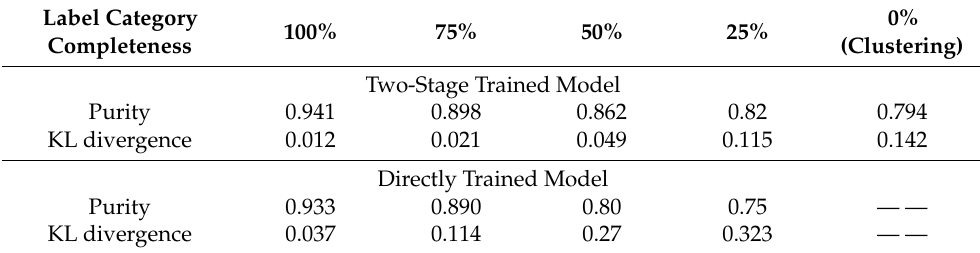
Figure 12. Loss curve during training. ( a1 ) Direct training on the full-label dataset; ( a2 ) direct training on incomplete labeled datasets; ( b1 ) fine-tuning on the full-label dataset; ( b2 ) fine-tuning on the incomplete label dataset. Table 4. Experimental results under different label category